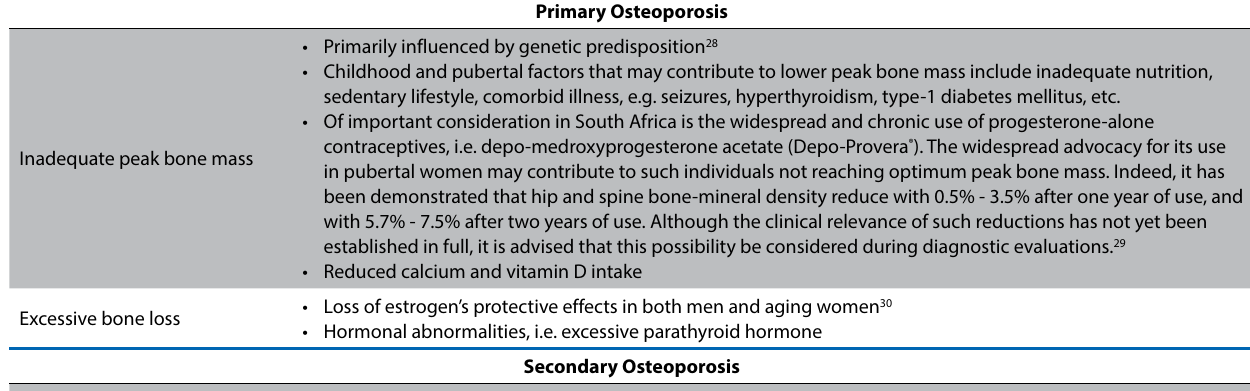
Primary Osteoporosis